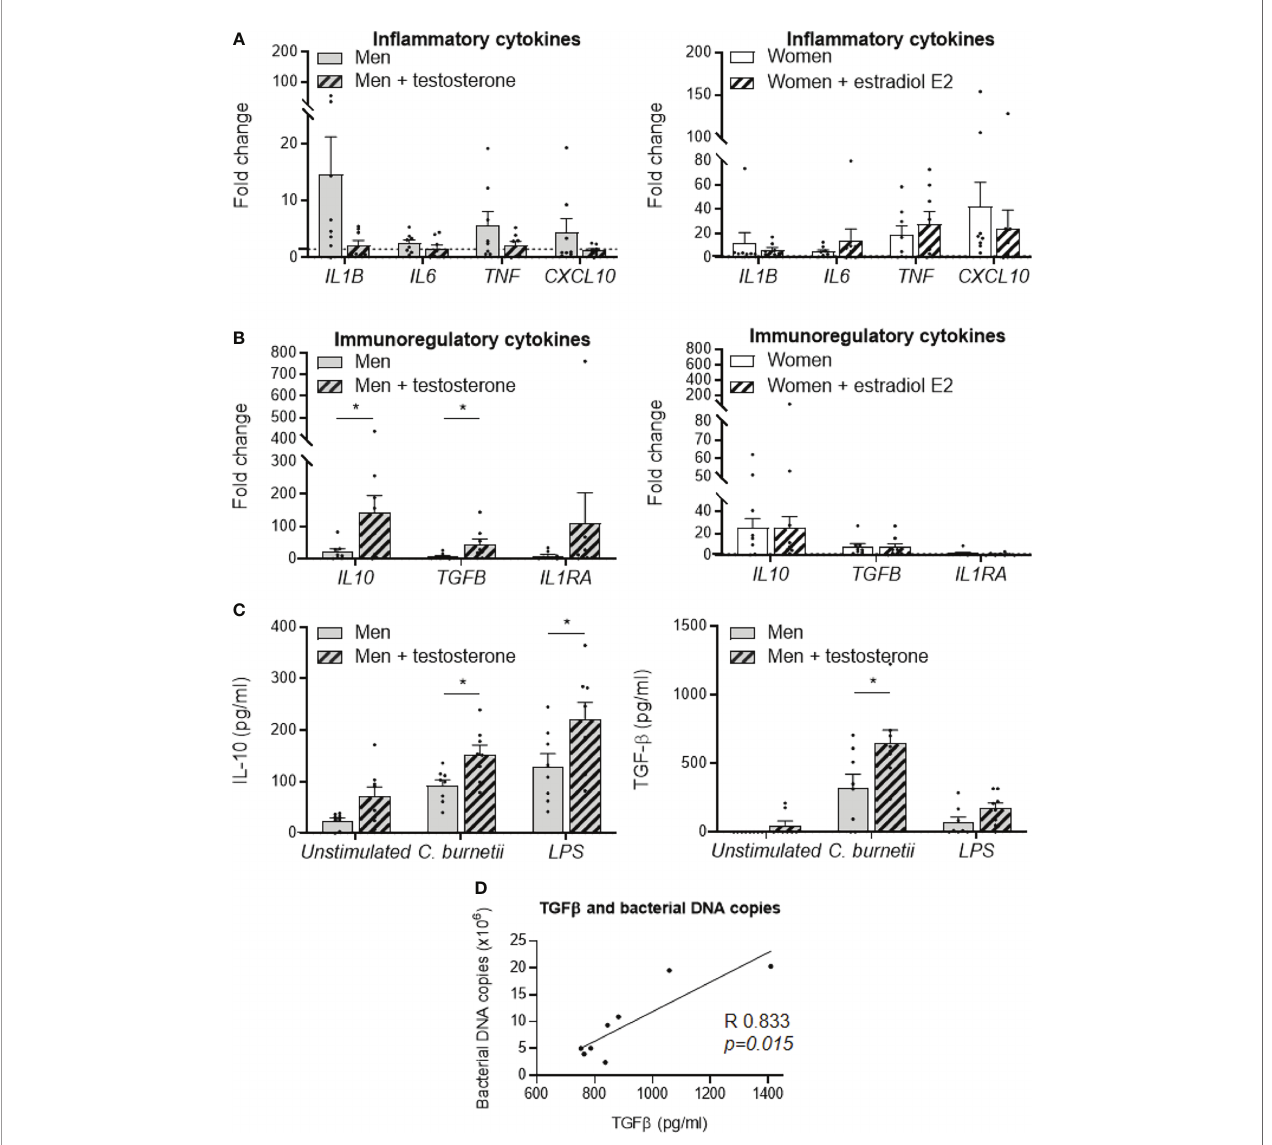
FIGURE 3 | Role of sex hormones in MDM responses to C. burnetii. MDMs from healthy donors from males (n=8) and females (n=8) were treated with testosterone and estradiol E2, respectively, for 24 hours before C. burnetii (50 bacteria per cell) stimulation. The expression of MDM (A) M 1 and (B) M 2 polarization genes was investigated by qRT-PCR, constant amount of total DNA and expressed as fold change relative to unstimulated cells was calculated. Gene expression was considered modulated when the fold change was ≥ 1.5 (indicated by the dotted line). Left panels concern MDMs from males +/- treated with testosterone and the right panels concern MDMs from females +/- treated with estradiol E2. (C) The release of IL-10 and TGF- b by MDMs from males (n=8) and females (n=8) infected by C. burnetii (50 bacteria per cell) or stimulated with 1 µg/mL LPS for 24 hours was determined by immunoassays. Data for men (in grey) and female (in white), with (striped bar) or without pre-treatment, represent mean ± standard error of the mean (duplicate was performed for each individual). Statistical analyses were performed using Mann-Whitney U test (men vs. women). * p ≤ 0.05. (D) Correlation between the levels of released TGF- b and the number of C. burnetii DNA copies uptake by MDMs from males after 24 h. Statistical analysis was performed using Spearman